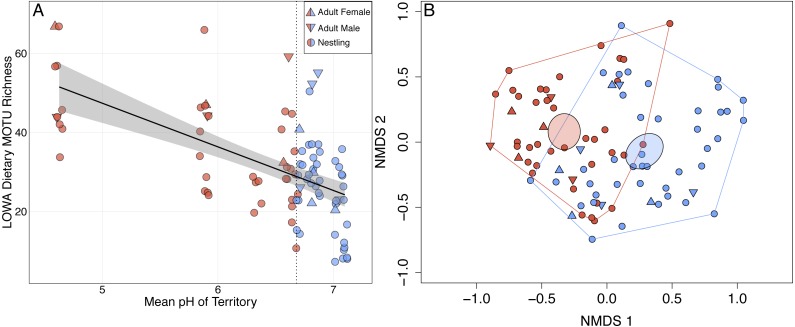
Shifts in adult and nestling Louisiana Waterthrush (LOWA) diet in response to stream acidification.(A) MOTU richness of adult (females, triangles; males, inverted triangles) and nestling (circles) diets increased significantly as mean territory pH declined (\documentclass[12pt]{minimal}
\usepackage{amsmath}
\usepackage{wasysym}
\usepackage{amsfonts}
\usepackage{amssymb}
\usepackage{amsbsy}
\usepackage{upgreek}
\usepackage{mathrsfs}
\setlength{\oddsidemargin}{-69pt}
\begin{document}
}{}${X}_{5,6}^{2}=10.80$\end{document}X5,62=10.80; P = 0.001). Point shading indicates whether a fecal sample was collected from a territory with a pH ≤ (red) or > (blue) the median value of 6.68 (vertical dotted line). Gray shading represents the 95% confidence interval. (B) Unconstrained NMDS ordination (stress = 0.255) of adult (females, triangles; males, inverted triangles) and nestling (circles) diet composition at the MOTU level. Points represent the taxonomic composition of waterthrush diets and shading indicates that the individual occupied a territory with a pH ≤ (red) or > (blue) the median value of 6.68. Ellipses represent 95% confidence intervals (based on standard error) for group centroids and minimum convex polygons indicate the extent of dietary niche space for each group.